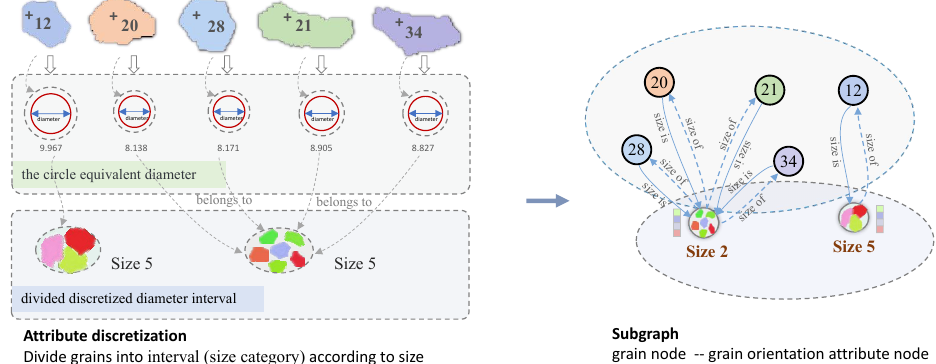
Attribute discretization Divide grains into interval (size category) according to size Figure 6. Grain-size edge construction. First, the corresponding size categories of grains are cal- culated, and then, the corresponding size category nodes (size attribute nodes) are connected to the grain nodes. In this way, the grain node and the corresponding size attribute node constitute a subordination